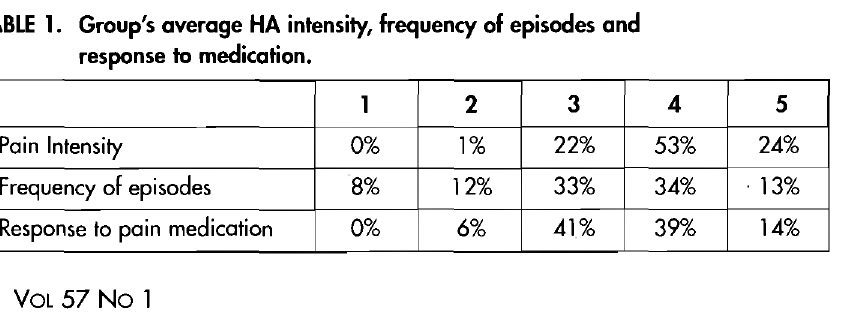
TABLE 1. Group's average HA intensity, frequency of episodes and response to